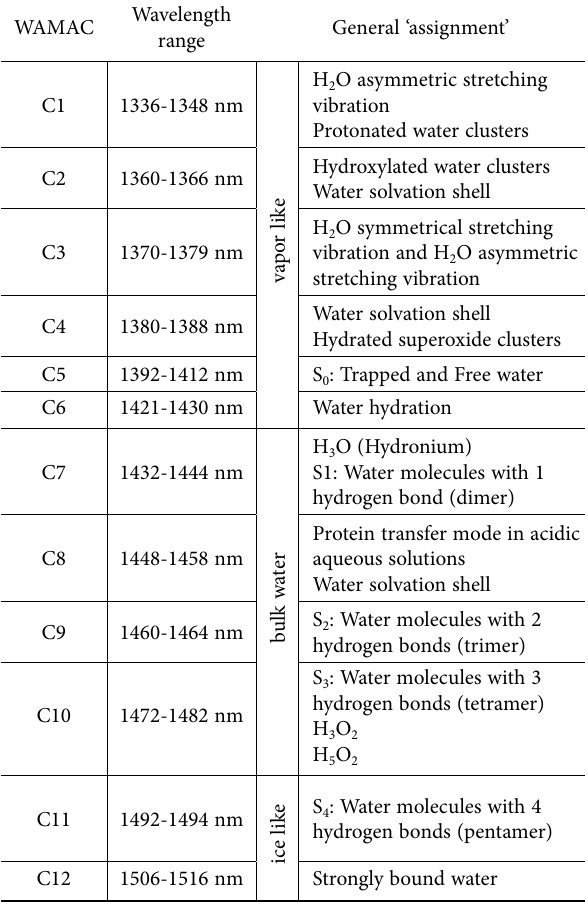
Table 1. The 12 WAMACS, their corresponding wavelength ranges, and the general ‘assignments’ often seen in R. Tsenkova’s experi- mental data. They are in good agreement with the respective pub- lished assigned bands in IR